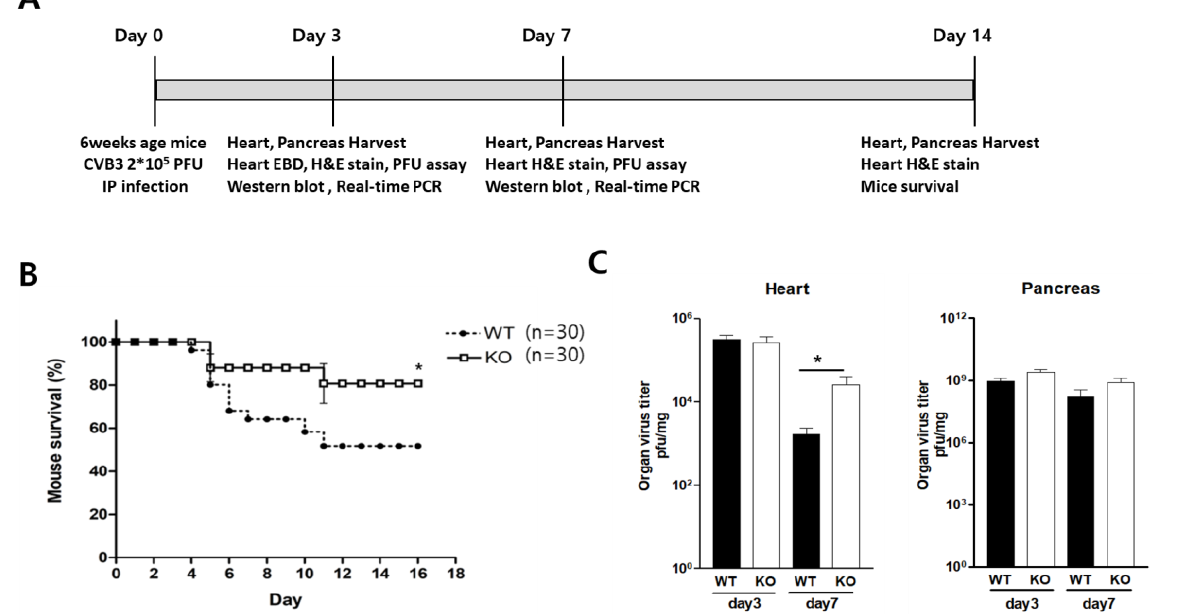
Figure 3. Macrophage-specific CAR deletion increased tissue virus replication but improved mouse survival. ( A ) CVB3 was injected intraperitoneally into WT and KO mice. ( B ) The mouse survival rate was recorded at day 14 p.i. (WT n = 30, KO n = 30). ( C ) The heart and pancreas were lysed on day three and day seven p.i. Tissue lysates were subjected to a plaque-forming unit (PFU) assay to measure the tissue virus titers. All data are expressed as the mean ± SEM. * p < 0.05, according to the two-tailed Student’s t -test.